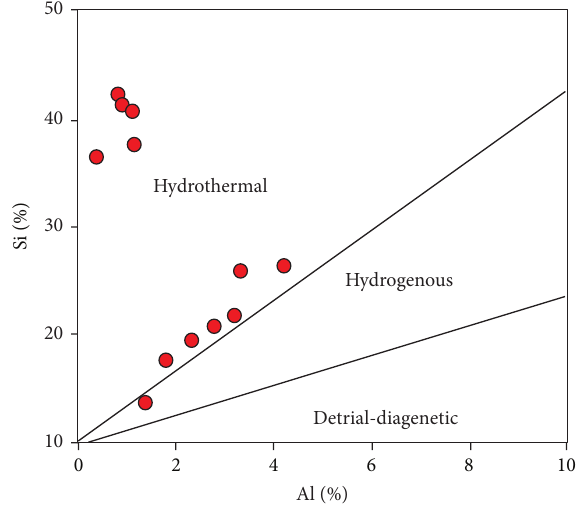
Figure 5: Si/Al diagram